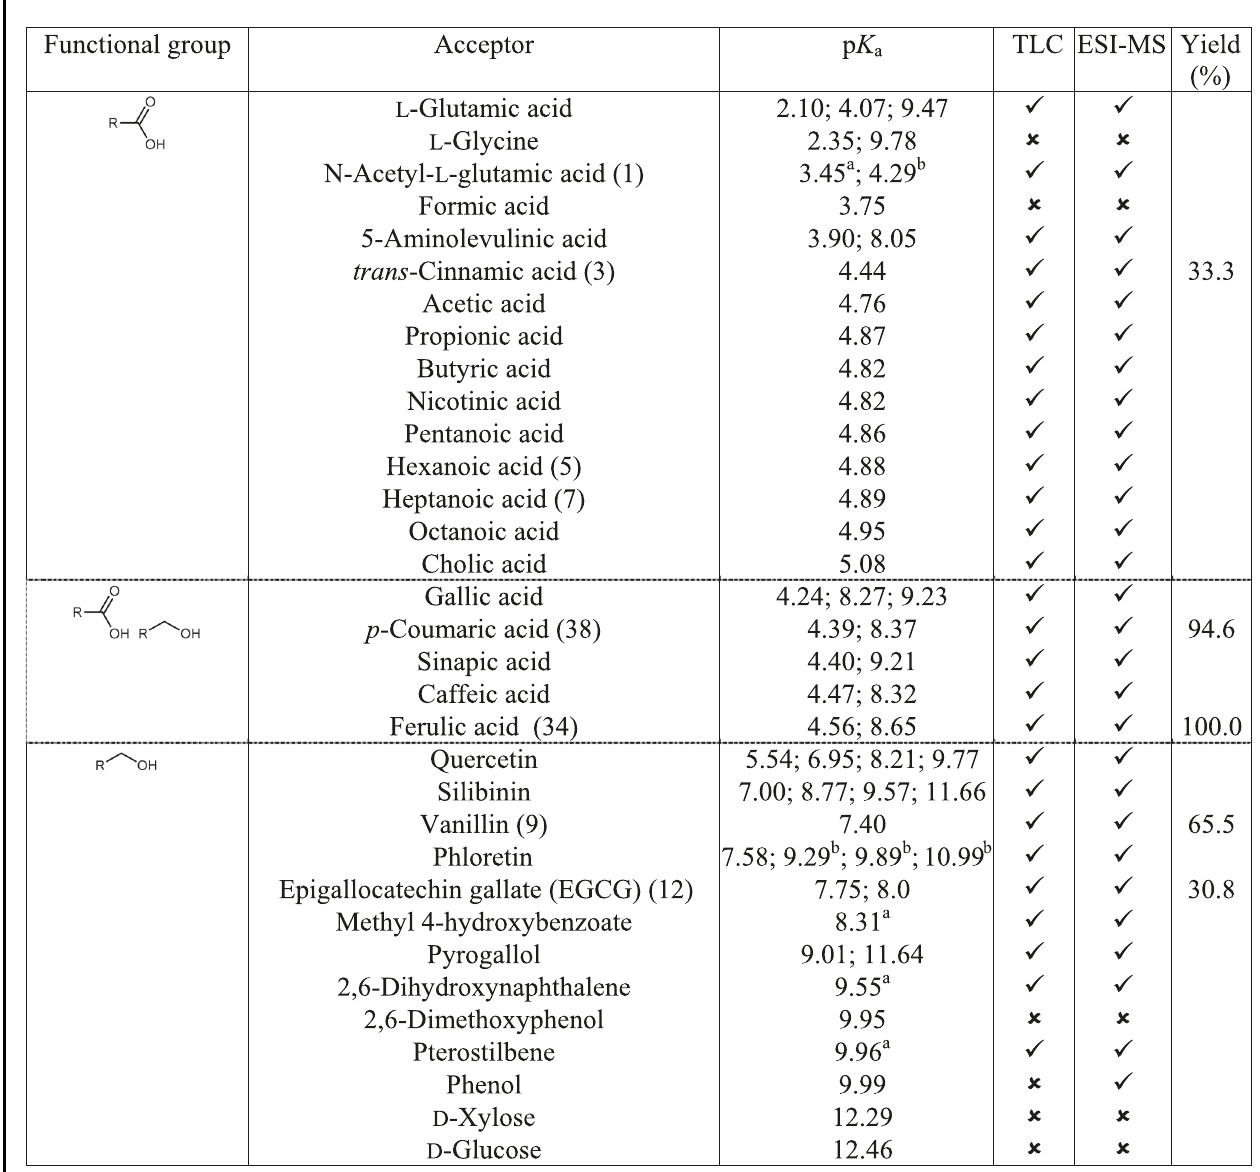
Table 1 Screening of acceptors for rBxTW1-E495A: carboxylic and alcohol target functional groups.